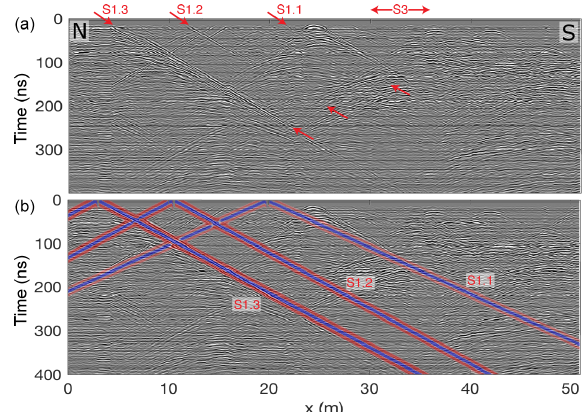
Figure 6. GPR reflection data measured from the AU tunnel in the N–S plane, looking west. These data are processed up to step 8 (Sect. 3.1.2) but not migrated. The shear zone locations inferred from the geological mapping are marked in panel (a) . Panel (b) shows as an overlay GPR reflections, which were modelled based on known shear zone locations and their average